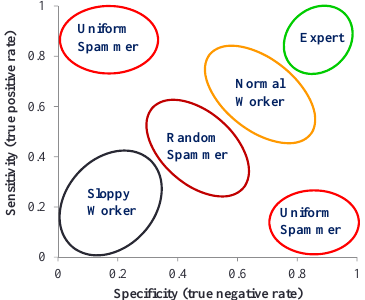
Figure 6. Effects of Spammer Ratio on Precision